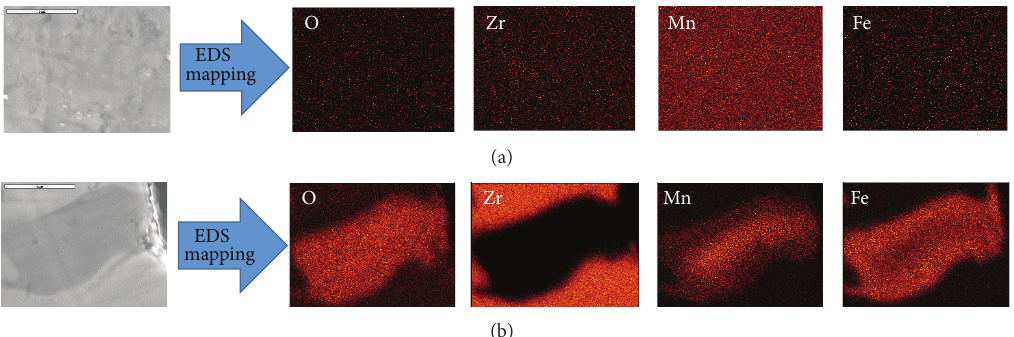
Figure 3: Sol-gel sample before (a) and after (b) calcination. SEM and EDS mapping at 10,000x magnification (the length of the scale bars in the SEM images is 5 𝜇 m).